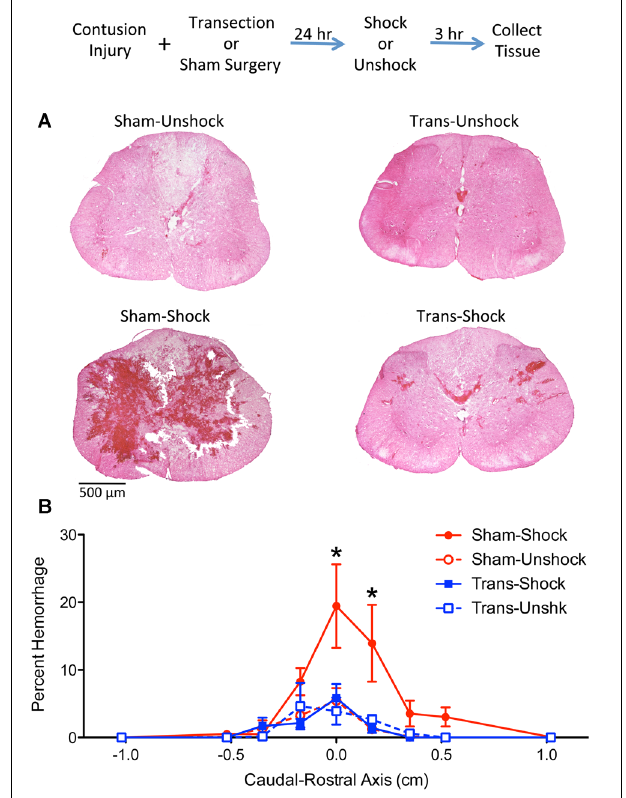
FIGURE 2 | Noxious electrical stimulation increased the area of hemorrhage in non-transected animals. The experimental design is illustrated at the top of the figure. Rats received a lower thoracic (T11–12 vertebrae) contusion injury and a spinal transection (Trans) at T2 or sham surgery. A day later, half the animals were exposed to electrical stimulation (Shock) or nothing (Unshock). Tissue was collected 3 h later, sectioned, and stained with H&E. (A) Noxious stimulation increased the area of hemorrhage at the epicenter of injury in non-transected rats that received shock (Sham-Shock). Areas of hemorrhage appear darkly stained (bar = 500 µ m). (B) Quantitation of hemorrhage extent over the caudal-rostral axis showed that the maximal effect was observed within 0.5 cm of the injury center and was positively skewed. Nociceptive stimulation did not amplify hemorrhage in spinally-transected rats (Trans-Shock). Error bars indicate the SEM. ∗ Indicates statistical significance ( p < 0.05, n =